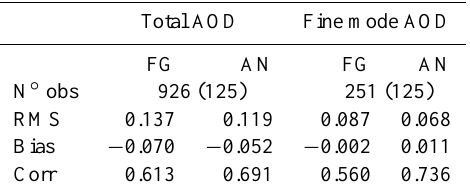
Table 4. Same as Table 3 but with statistics computed with respect to MODIS AOD. Statistics are computed considering as observation the closest MODIS pixel to the AERONET stations. Monthly aver- ages are computed using only days with AERONET observations.